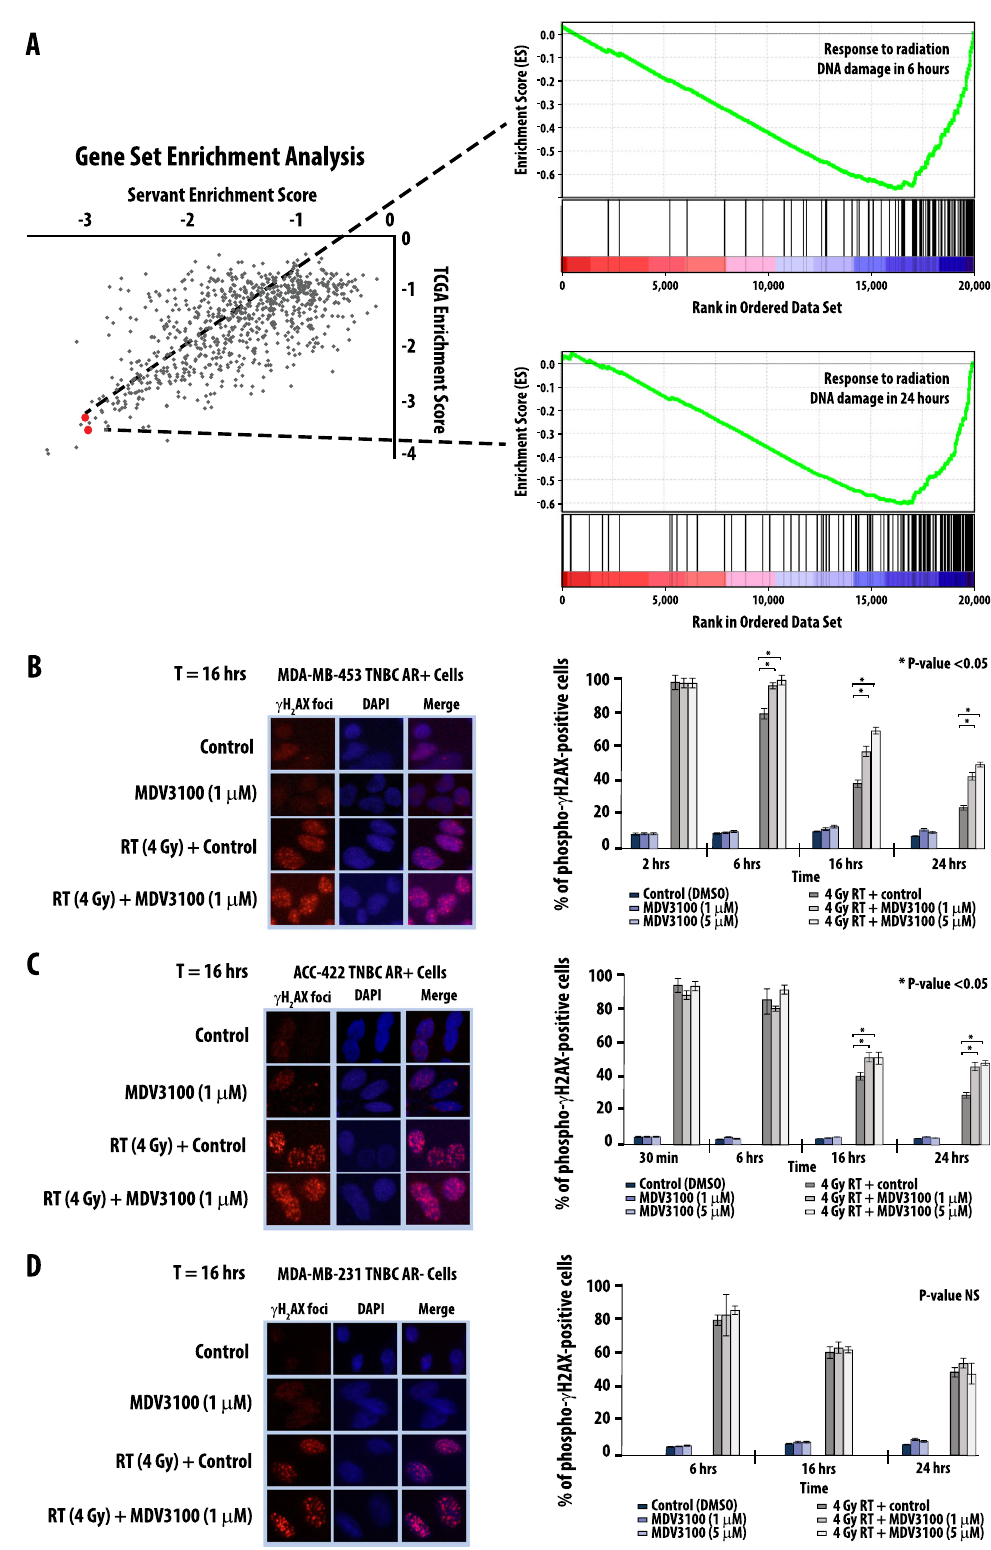
Fig. 5 GSEA analysis identi fi es DNA repair after ionizing radiation as a top concept associated with AR expression ( a ). AR inhibition through with MDV3100 signi fi cantly delays double stranded DNA break repair at 2, 6, and 16 h in the AR-positive TNBC cell lines MDA-MB-453 ( b ) and ACC-422 ( c ) but not the AR-negative TNBC cell line MDA-MB-231 ( d ). Cells were treated with MDV3100, RT, or combination and γ H2AX foci were manually counted. Images are representative of cells are the indicated time points. Minimum of 100 cells per condition were counted, and experiments were repeated in triplicate. Error bars represent